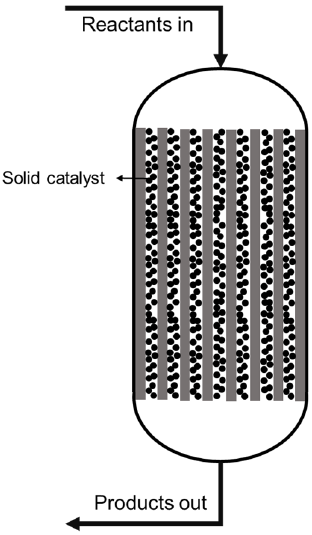
Figure 6. Illustration of the two-phase fixed-bed reactor.